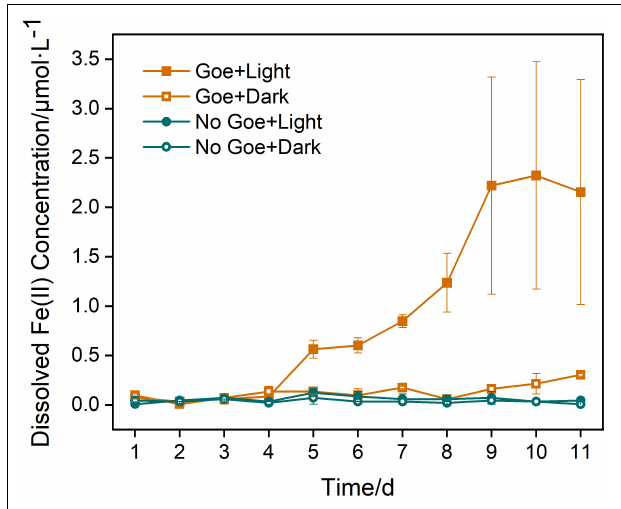
FIGURE 7 | Concentration of Fe(II) dissolved by photoreduction of goethite.